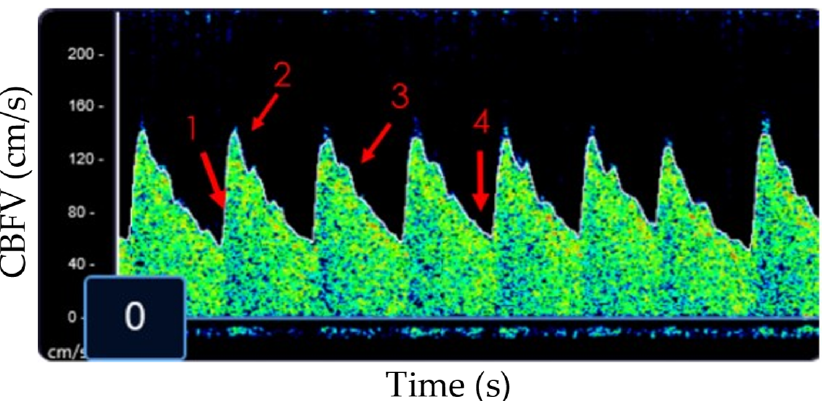
Figure 1. Example of a normal MCA waveform on a non-imaging TCD machine. 1: Beginning of systole; 2: peak systole; 3: dichrotic notch; 4: end-diastole. CBFV: cerebral blood flow velocity.